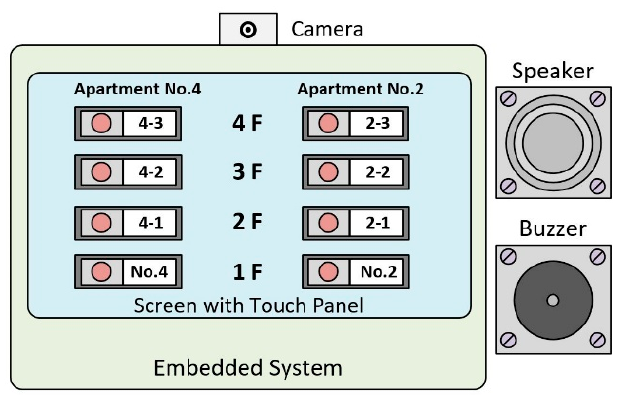
Figure 5. The touch screen layout of this system.